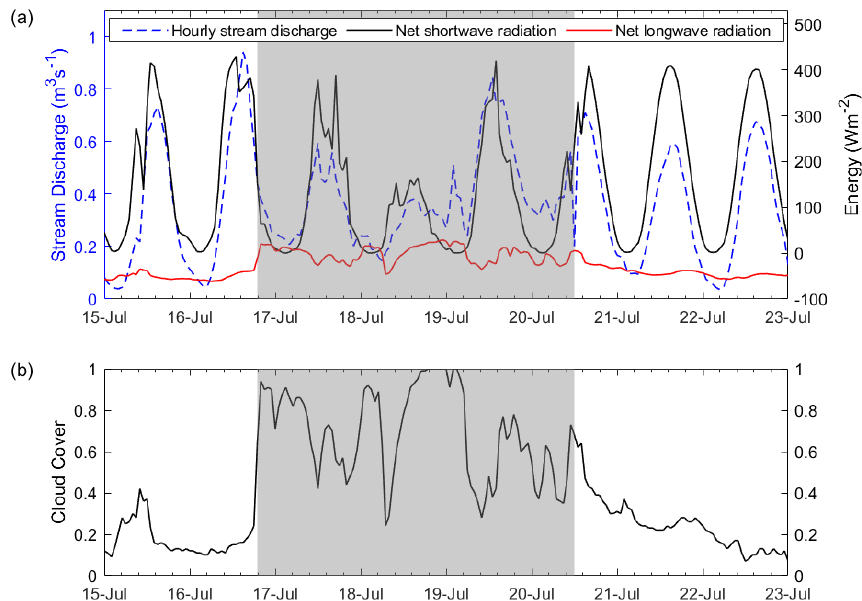
Figure 7. (a) Diurnal fluctuations in stream discharge on the left y axis (dashed blue line) and surface energy balance components on the right y axis, net shortwave radiation in black and net longwave radiation in red from 15–22 July. (b) Cloud cover at the KAN_L station from 15–22 July. The large daily minimum period (a subset of the third melt episode) with cloud cover consistently greater than 0.4, except for a couple of hours throughout a 96h period, is shown in the grey-shaded region.